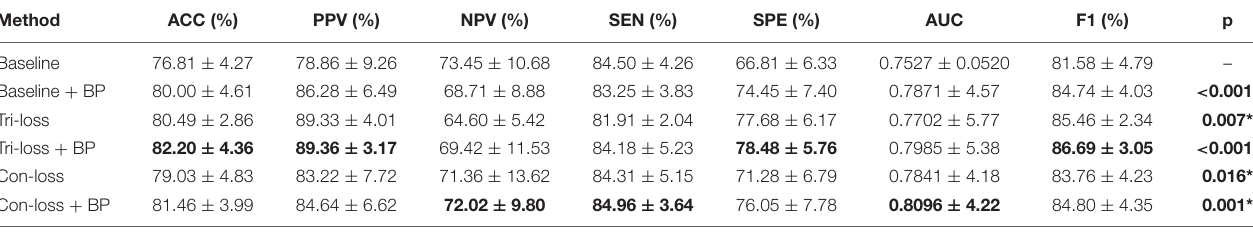
TABLE 4 | Results of the ablation studies of BP module and metric learning loss for NC VS. LMCI classification (Mean ± Standard Deviation).